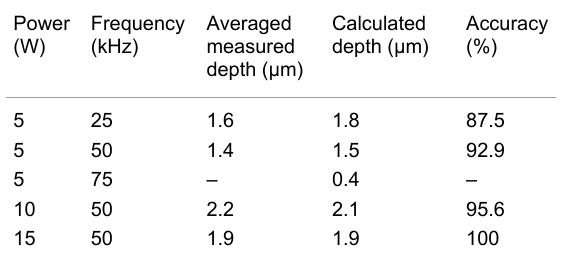
Table 1: Measured and calculated data for the ablation cross-section for uncoated Si